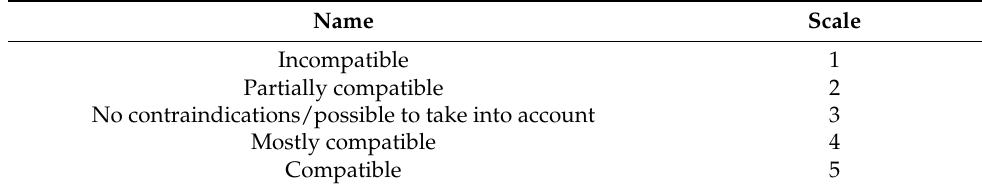
Table 2. Numerical evaluation scale of the sub-criterion X 3,3 —investment compliance with local policies.